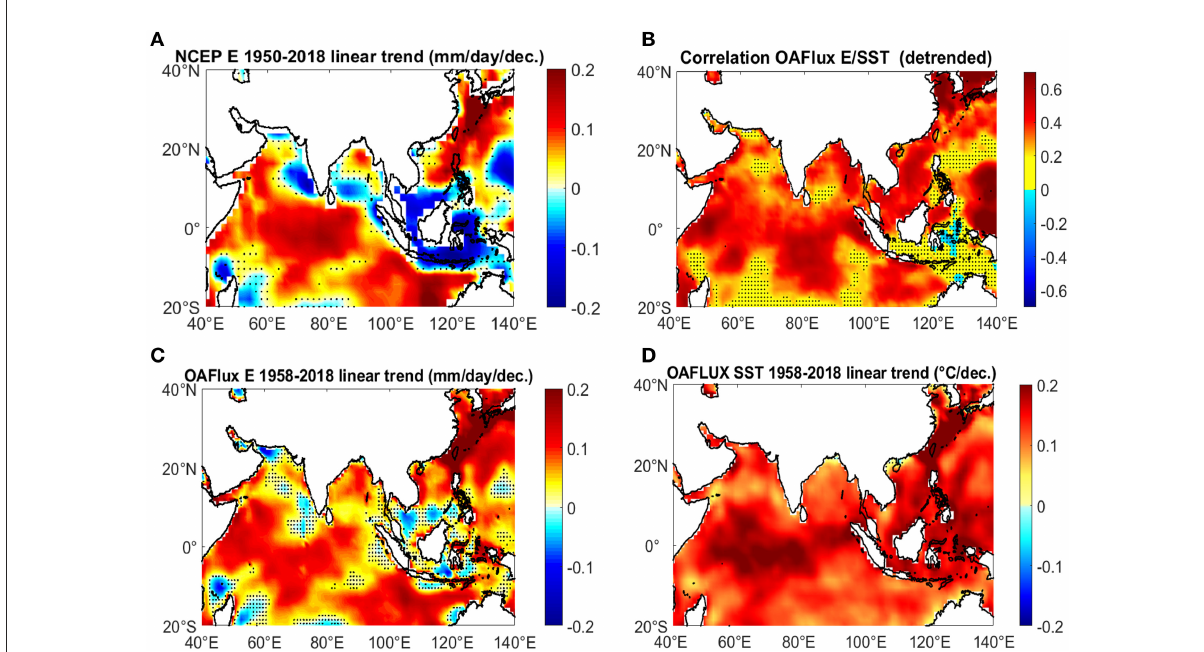
FIGURE7 (A) Linear trends in evaporation (mm/day/decade) from OAFlux (1958–2018); (B) Correlation spatial pattern between annual mean evaporation (OAFlux) and SST (OAFlux) anomaly timeseries (detrended). (C) Linear trends in evaporation (mm/day/decade) from NCEP/NCAR (1950–2018); (D) Linear trend in SST (OAFlux) over 1958–2018 ( ◦ C/decade). Regions where the linear trend/correlation is not significant at the 95% confidence interval are